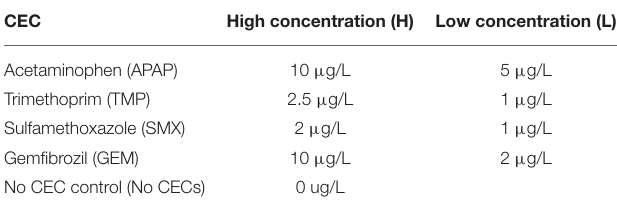
TABLE 1 | Concentrations of CECs used for all assays in this study. CEC High concentration (H) Low concentration (L) Acetaminophen (APAP) 10 µ g/L 5 µ